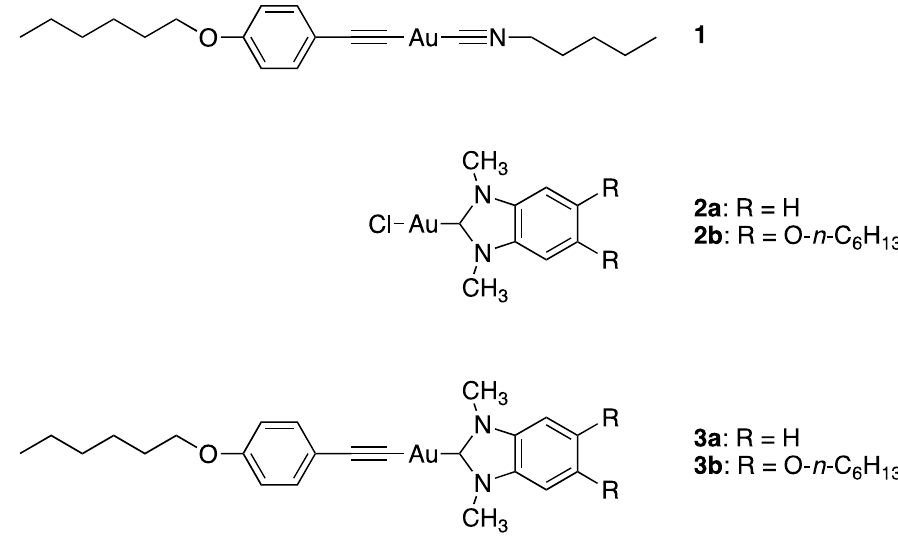
Figure 1. Molecular structure of gold complexes used in this study.